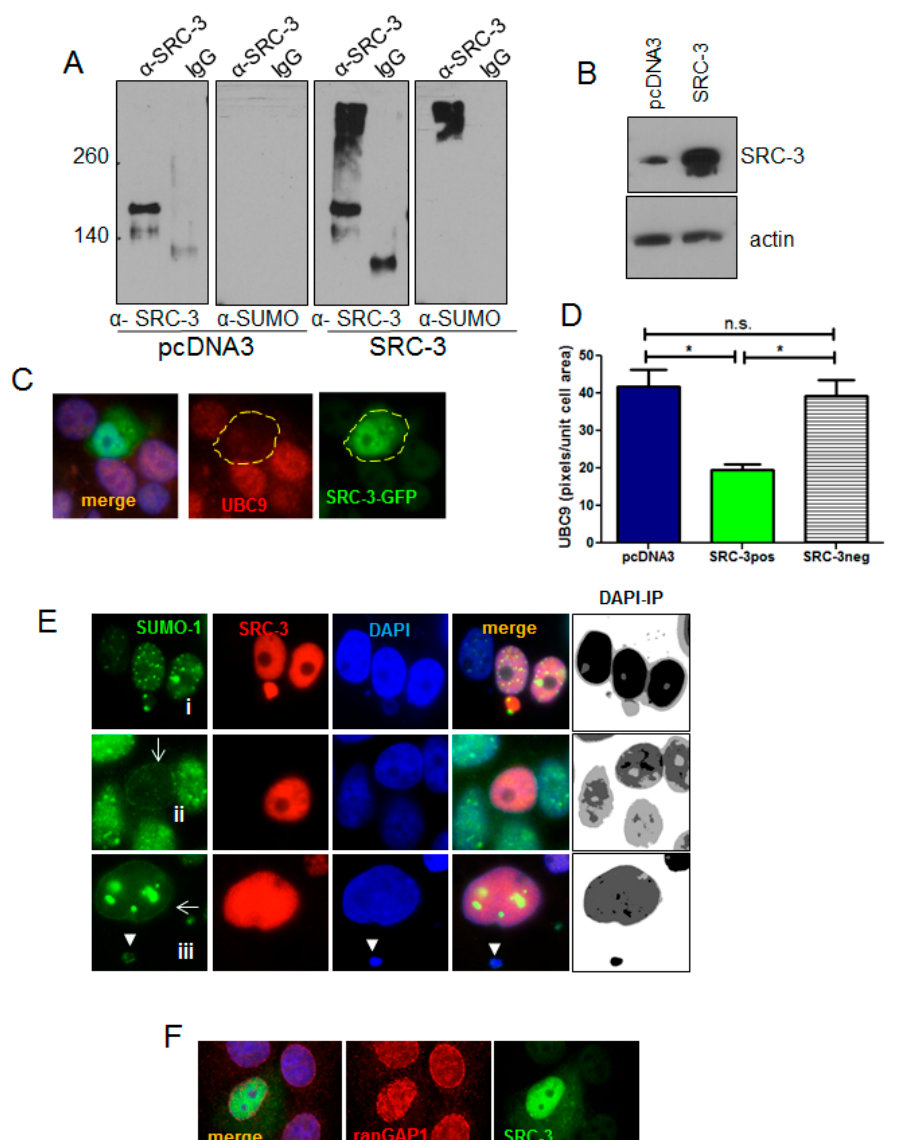
Figure7. OverexpressedSRC-3isSUMOylatedanddisruptstheSUMOpathway. ( A )Immunoprecipitation of protein from control (pcDNA3) or SRC-3 transfected MCF-7 cells using anti-SRC-3 or non-immune IgG was immunoblotted with anti-SUMO and anti-SRC-3. ( B ) SRC-3 immunoblot of input cell lysates in A as indicated. ( C ) MCF-7 cells were transfected with SRC-3-GFP then IF performed for UBC9. A representative cell expressing transfected SRC-3 (SRC-3-GFP + ) is shown (63 × magnification). ( D ) Graph depicting mean of UBC9 pixels / nuclear area within cells transfected with SRC-3-GFP ( n = 12 GFP pos cells and n = 20 GFP neg cells as shown) or transfected with pcDNA3 ( n = 25 cells) ± S.E. * p < 0.05 (paired t-test). ( E ) Examples of SUMO IF in SRC-3 overexpressing MCF-7 cells. Panel (i): SUMO-1 puncta in the nucleus and associated with an SRC-3 / chromatin nuclear protrusion. Panel (ii): Nuclear membrane-associated SUMO-1 with loss of nuclear puncta in an SRC-3 overexpressing cell. Panel (iii): MCF-7 cell with SUMO-1 aggregates and SUMO-1 distribution at the nuclear membrane. Note the absence of detectable nucleoli. Images on the right of each panel represent inverted and posturized (IP) DAPI channel images (Photoshop CS6) to visualize extranuclear DNA. ( F ) RanGAP1 IF (red) in MCF-7 cells transfected with SRC-3 (green) shows redistribution of ranGAP1 at the nuclear periphery. DNA is stained with DAPI (blue) (E and F, 63 ×